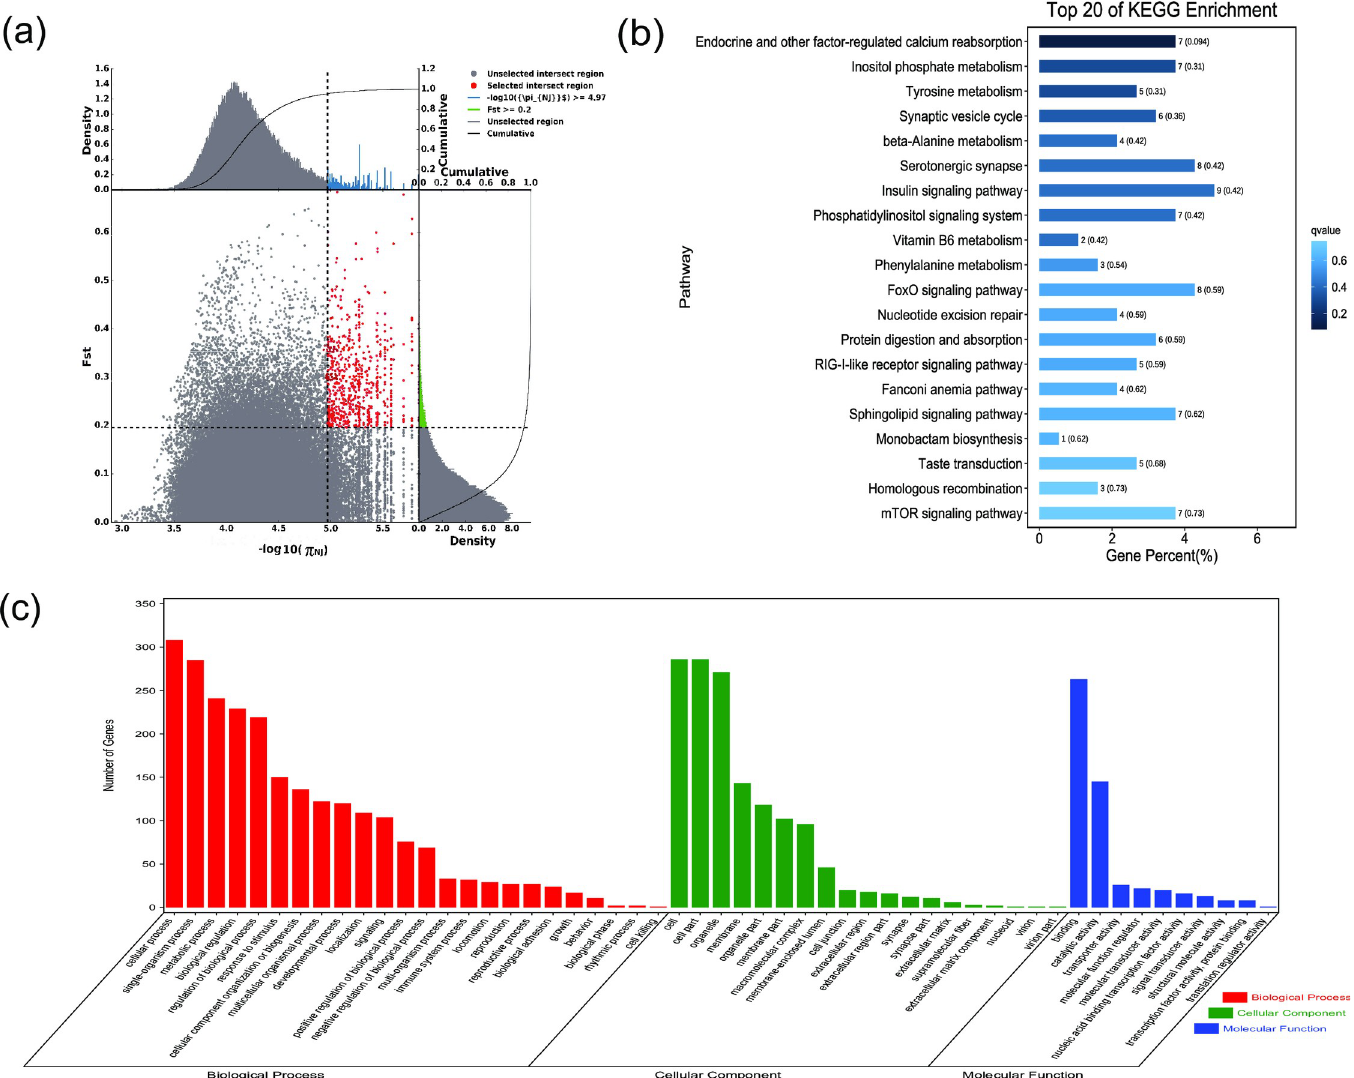
Fig 2. GO classification and KEGG enrichment of the selected genes of Nanjiang camels. (a) With the pool of all remaining others as the reference population and Nanjiang camels as the target population, 603 selected genes were obtained. (b) KEGG enrichment of 603 selected genes of Nanjiang camels. (c) GO classification of 603 selected genes of Nanjiang